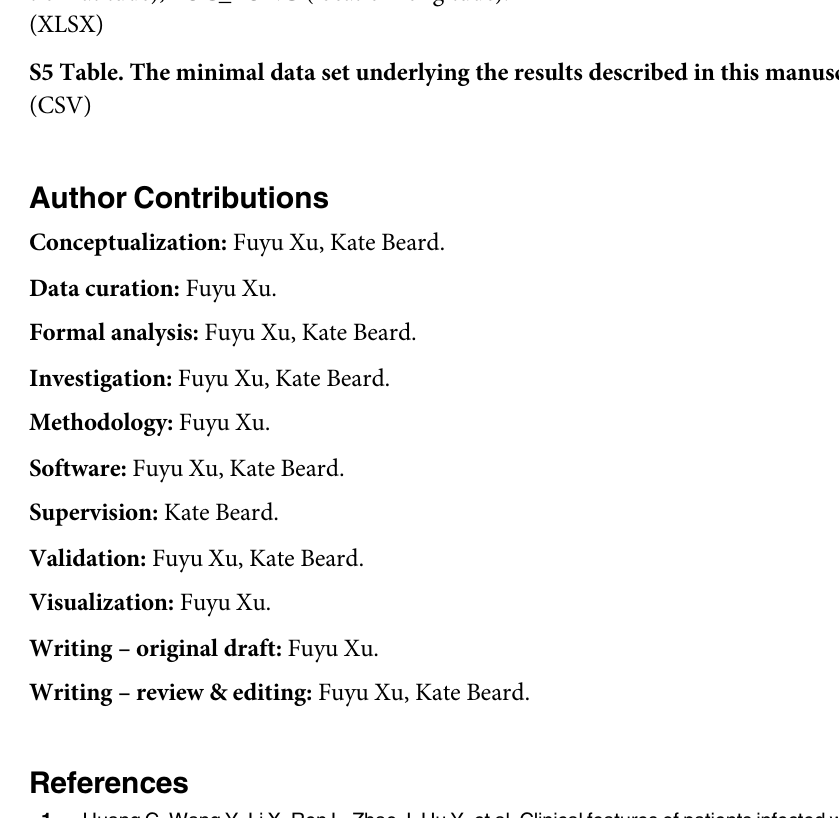
S2 Table. Comparison of space-time clusters from SaTScan and STES based hierarchical clustering with the dataset from 1/23-3-31/2020. This table is merged through FIPS of US counties, and also includes other selected output parameters from SaTScan such as p-values, LOC_RR (location or county relative risk), CLU_RR (cluster relative risk), LOC_LAT (loca- tion latitude), LOC_LONG (location longitude). S3 Table. Comparison of space-time clusters from SaTScan and STES based hierarchical clustering with the dataset from 1/23-4-19/2020. This table is merged through FIPS of US counties, and also includes other selected output parameters from SaTScan such as p-values, LOC_RR (location or county relative risk), CLU_RR (cluster relative risk), LOC_LAT (loca- tion latitude), LOC_LONG (location longitude). S4 Table. Comparison of space-time clusters from SaTScan and STES based hierarchical clustering with the dataset from 1/23-5-20/2020. This table is merged through FIPS of US counties, and also includes other selected output parameters from SaTScan such as p-values, LOC_RR (location or county relative risk), CLU_RR (cluster relative risk), LOC_LAT (loca- tion latitude), LOC_LONG (location longitude). S5 Table. The minimal data set underlying the results described in this manuscript.